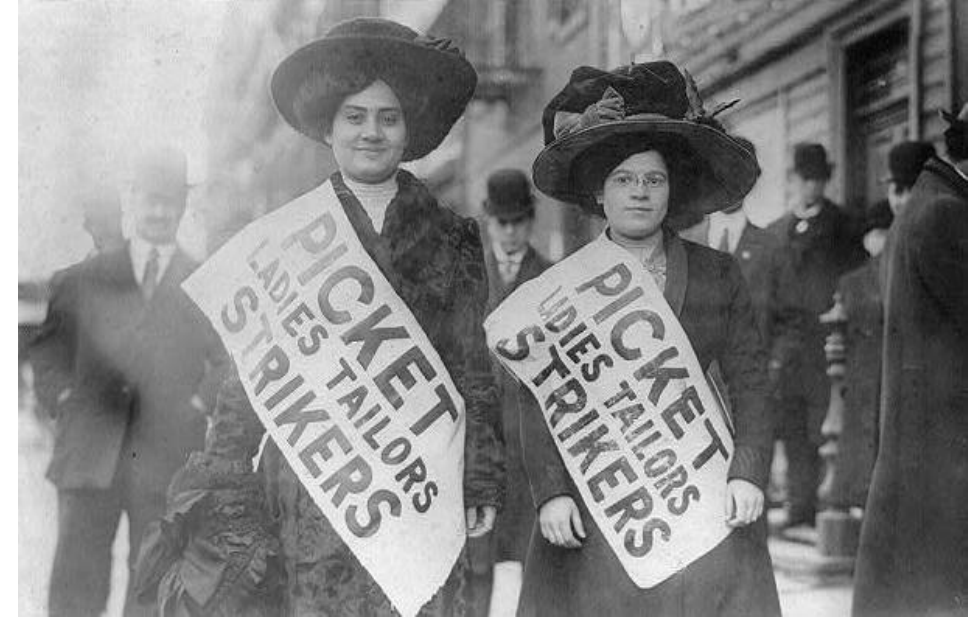
Figure 3. Women tailors on strike, Uprising of 20,000, 1909. Wikipedia Commons.